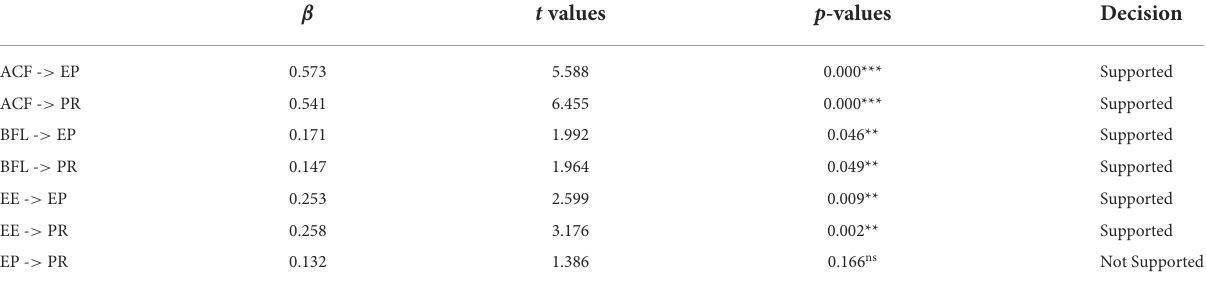
TABLE 4 Path coefficient results.